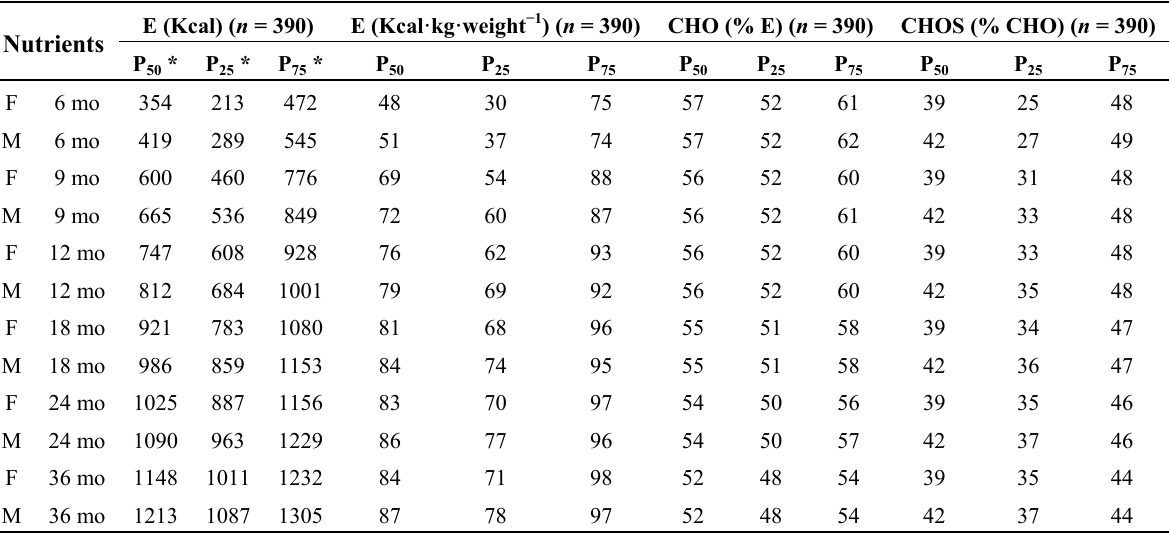
Table 5. Percentiles of energy and carbohydrate intake in the pooled sample of NI636 children. Nutrients